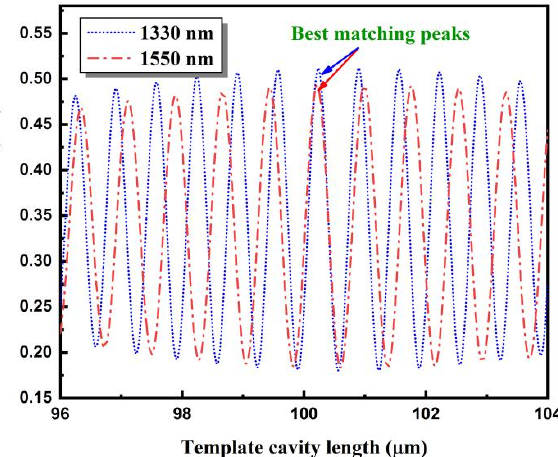
Figure 11. Normalized reflection spectra in the spectra ranges covered by ( a ) 1330 nm SLD and ( b ) 1550 nm SLD.